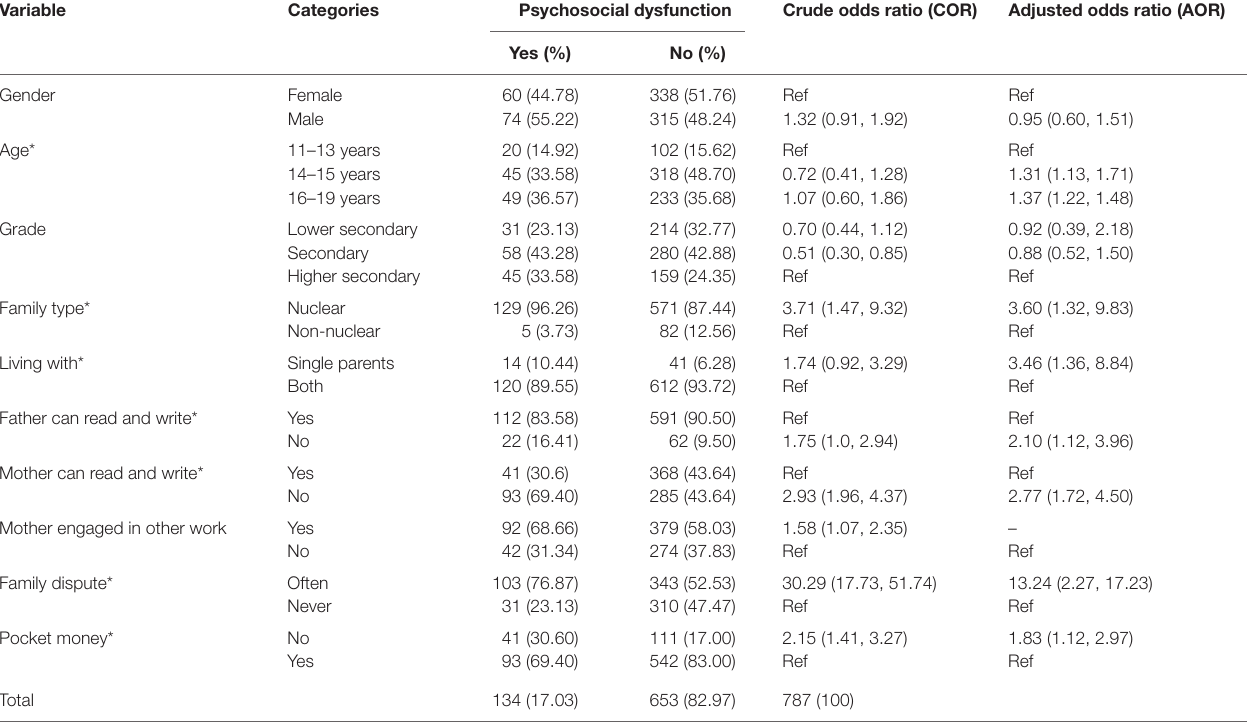
TaBle 2 | Factors affecting psychosocial dysfunction among the respondents.